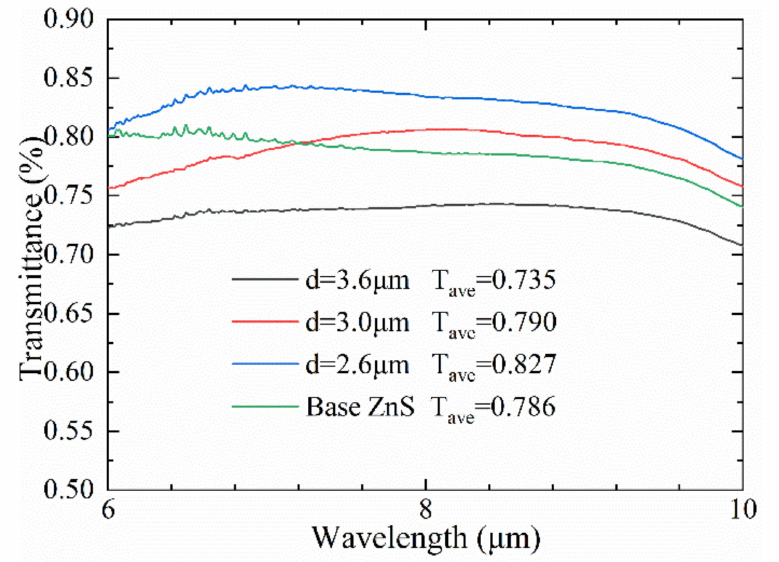
Figure 6. IR transmittance of the ZnS before and after ablating microhole